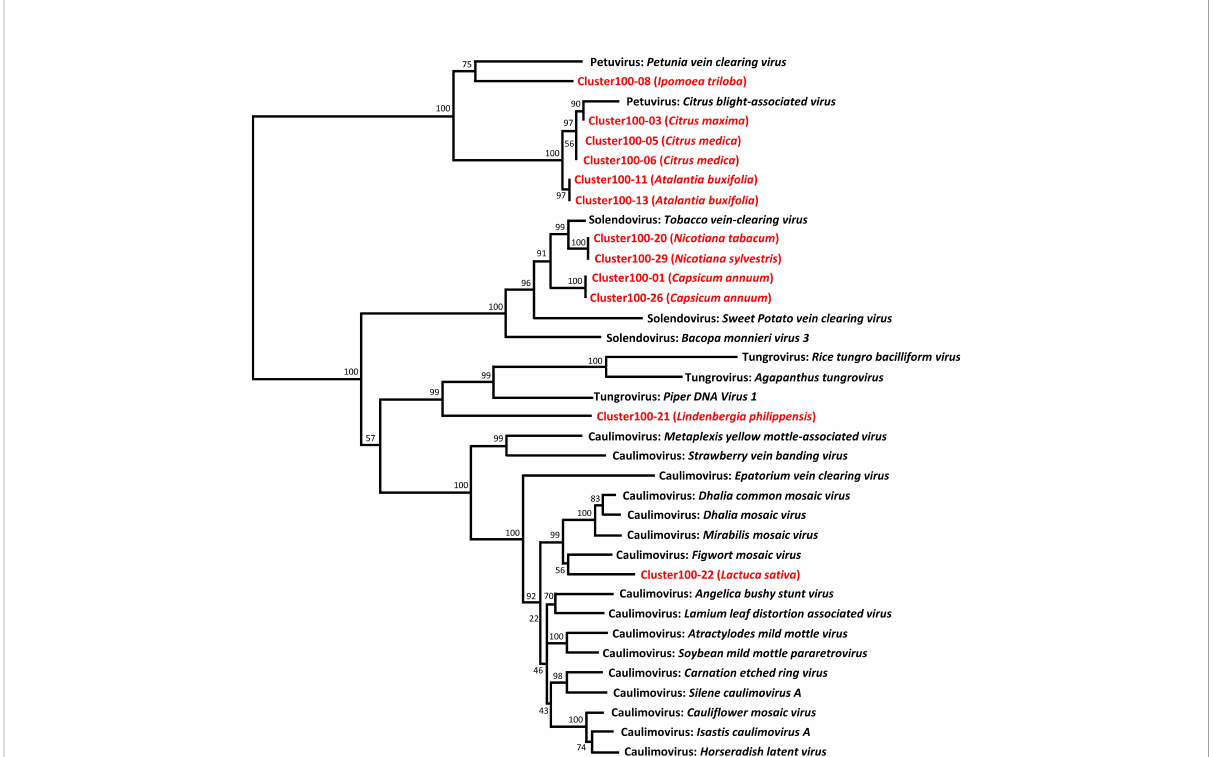
FIGURE 2 Phylogenetic relationships of representative sequences of the Cluster100. Representative sequences of the RT-EPRV Cluster100 (in red) were aligned with RT sequences of pararetroviral elements (in black), and a phylogenetic tree was constructed using the NJ method and 1000 bootstrap